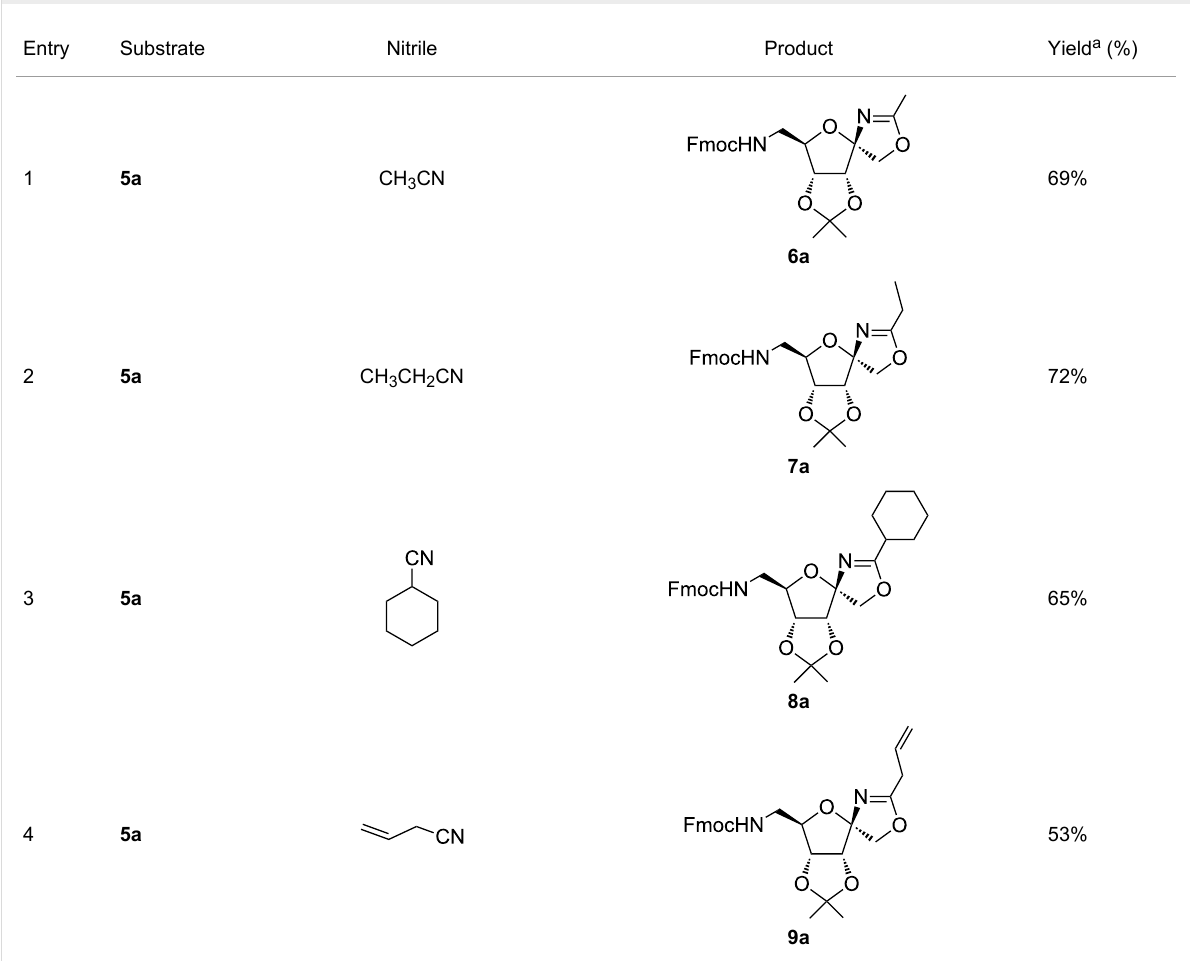
Table 1: Synthesis of spiro 2-substituted-2-oxazolines 6a–18a